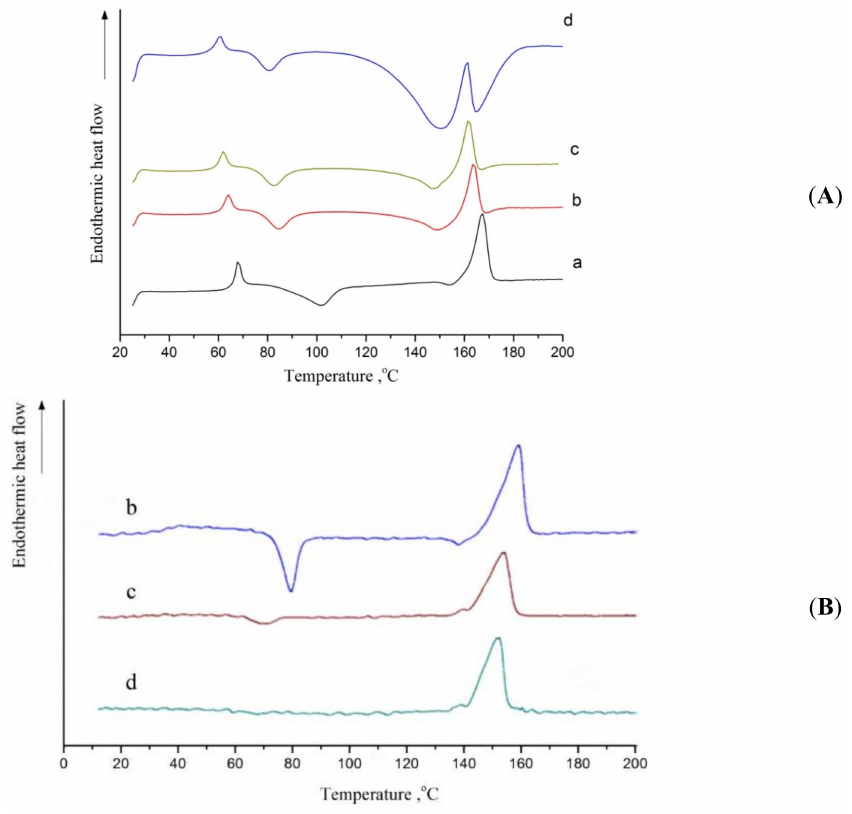
Figure 9. DSC curves of the first heating scan ( A ) and second heating scan ( B ) for pristine PLA fibrous material (a) and PLA fibrous materials with 1% (b), 3% (c) and 5% (d) added OTOA, respectively. Table 4. Thermal parameters for the studied PLA fibrous materials (first